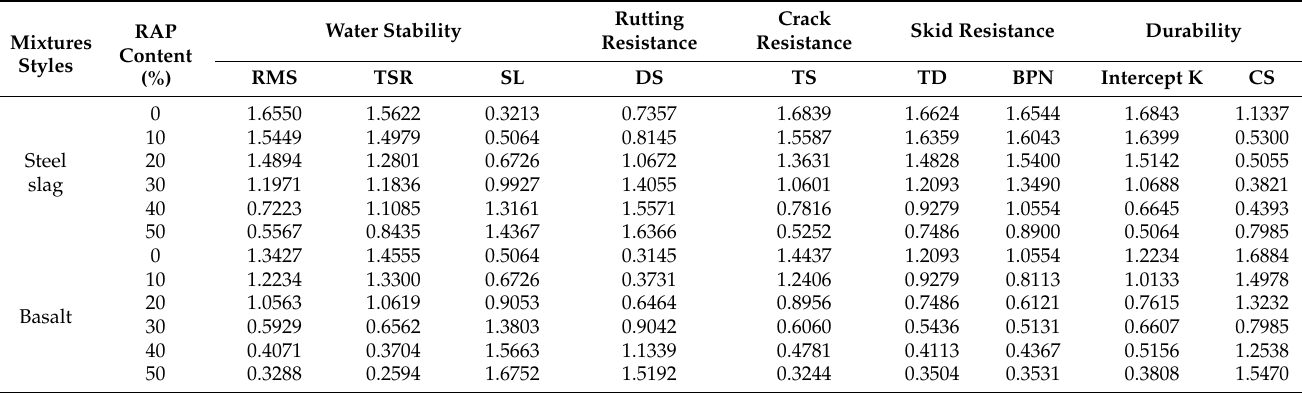
Table 7. Evaluation indicators after standardization and non-linear transformation.